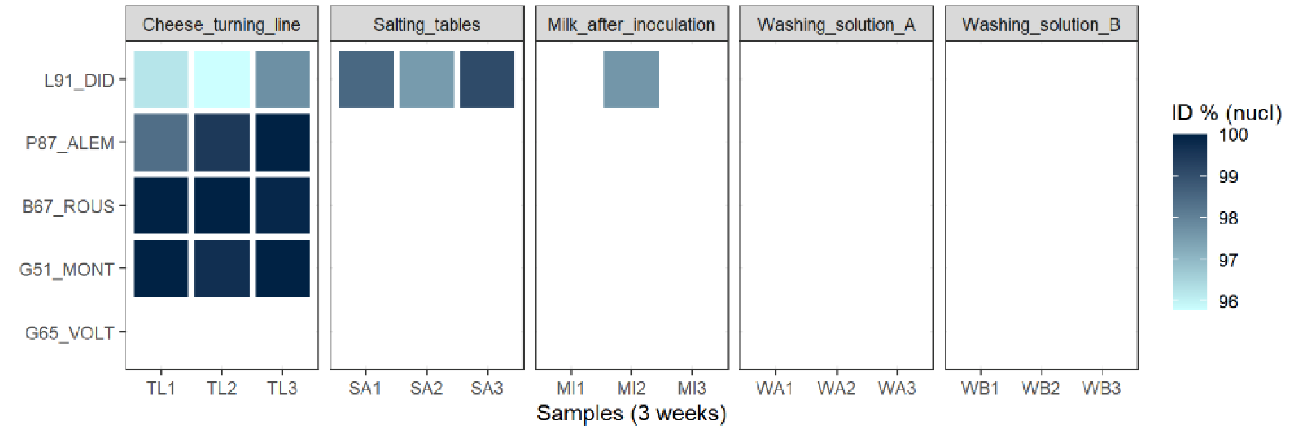
Figure 5. Sensitivity of indicator strains to phages present in different samples collected within the dairy